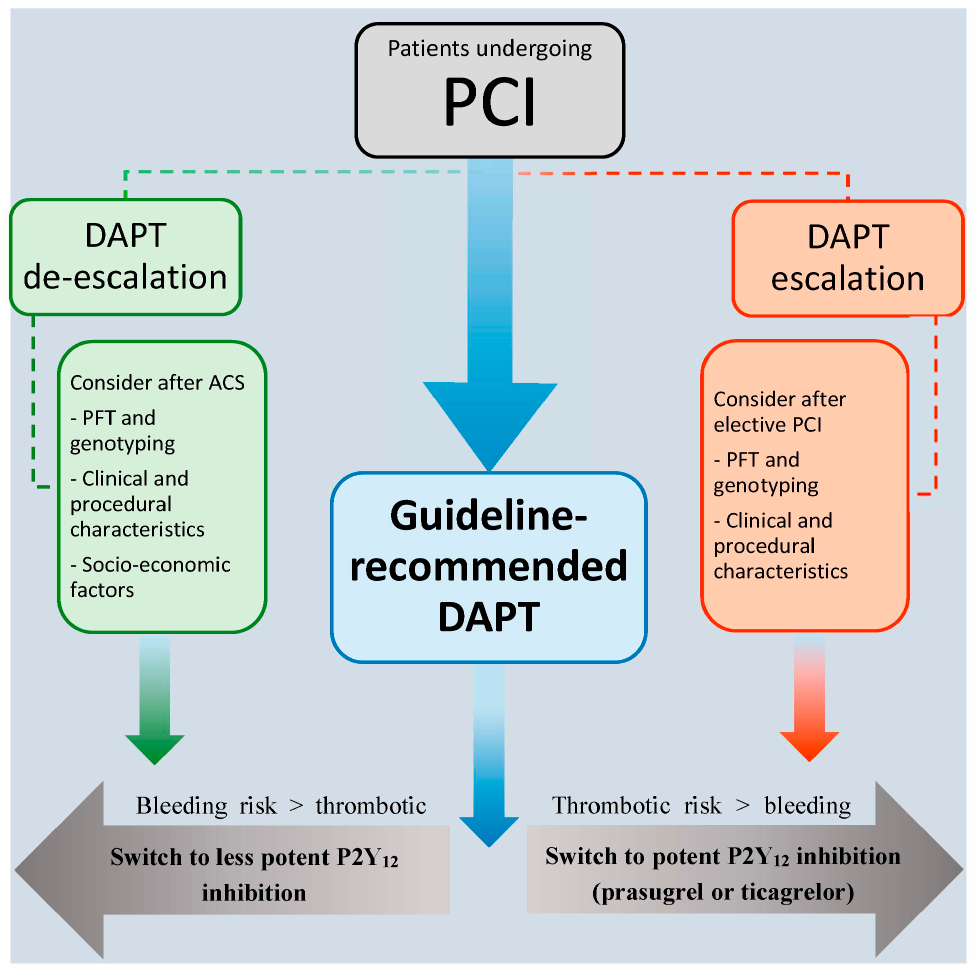
Figure 1. Strategies for dual antiplatelet therapy after PCI. The majority of patients undergoing percutaneous coronary intervention (PCI) should be treated with guideline recommended dual antiplatelet therapy (DAPT) (clopidogrel in elective PCI and ticagrelor or prasugrel in patients with acute coronary syndrome (ACS)). In elective PCI patients, an escalation strategy can be considered in some situations, when the thrombotic risk is higher than the bleeding risk. In ACS patients, de-escalation can be considered when the bleeding risk is higher than the thrombotic risk or for socio-economic